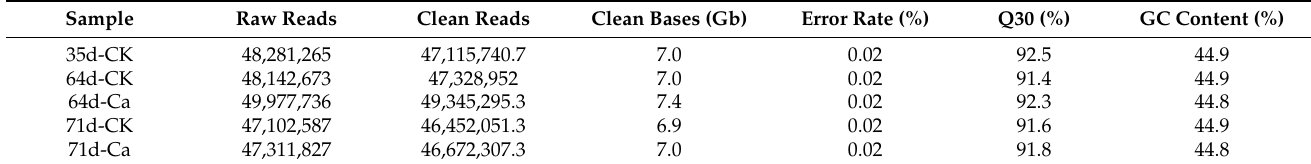
Table 1. Statistics of transcriptome sequencing data from the pulp of Feizixiao lychee fruit in the high-Ca treatment and CK treatment groups.